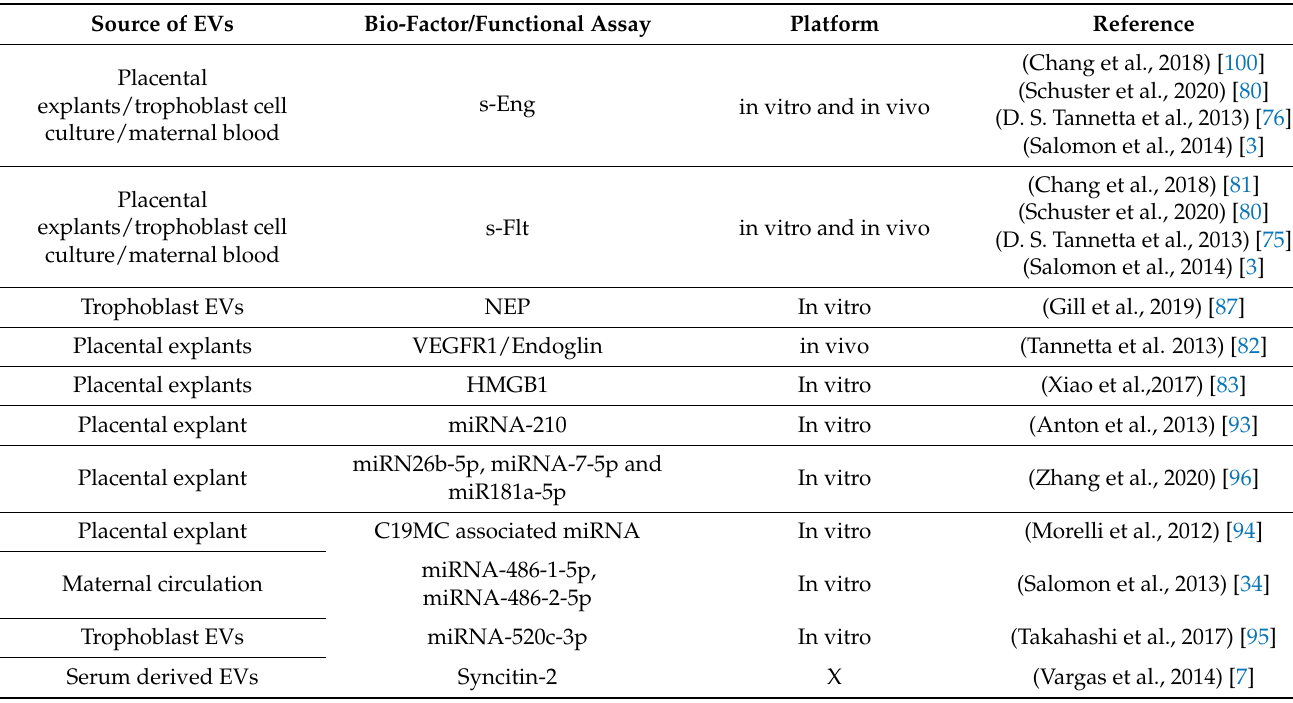
Table 2. Angiogenic factors associated with EVs and their role in